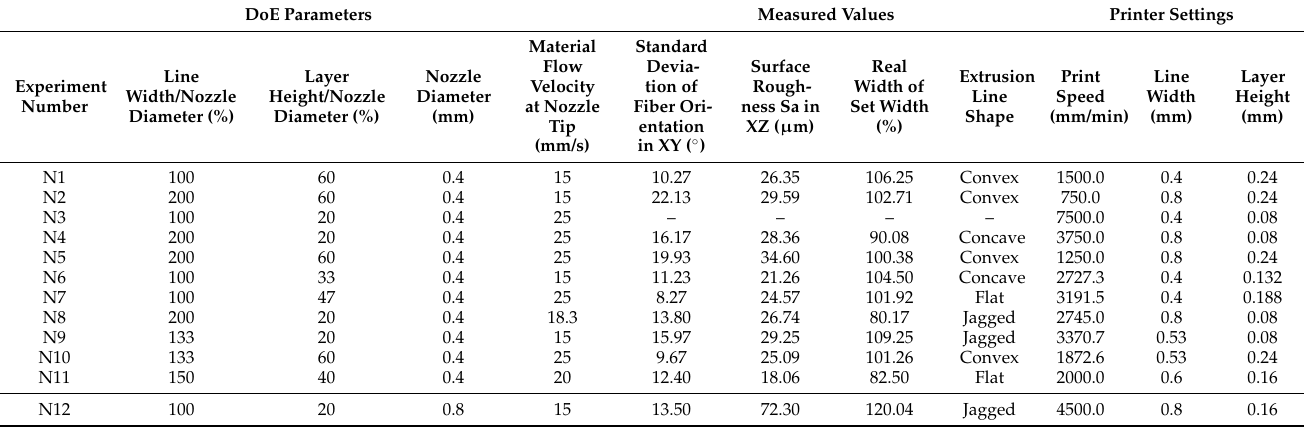
Table A1. Overview of DoE experiment parameters, measured results and corresponding printer